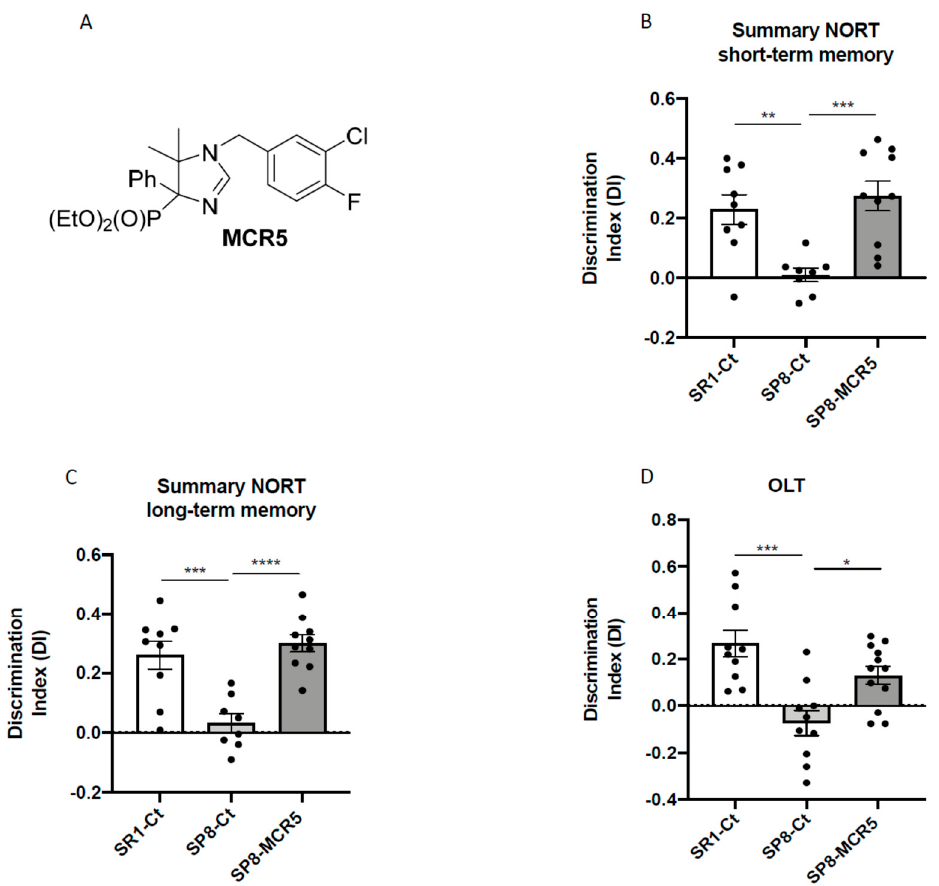
Figure 2. Structure of I 2 -IR ligand MCR5 ( A ). Results of Novel object recognition test (NORT), and Object location test (OLT) in male mice at 10-month-old SR1 and SP8 Ct mice groups and SP8 treated with I 2 -IR ligand MCR5 (5 mg / Kg) mice group. For NORT: Summary of Discrimination Index (DI) from short-term memory ( B ) , and summary of DI from long-term memory ( C ). For OLT: Summary of DI ( D ). Values represented are mean ± Standard error of the mean (SEM); n = 36 (SR1-Ct n = 11; SP8-Ct n = 11; SP8-MCR5 n = 14). * p < 0.05; ** p < 0.01; *** p < 0.001; **** p < 0.0001.